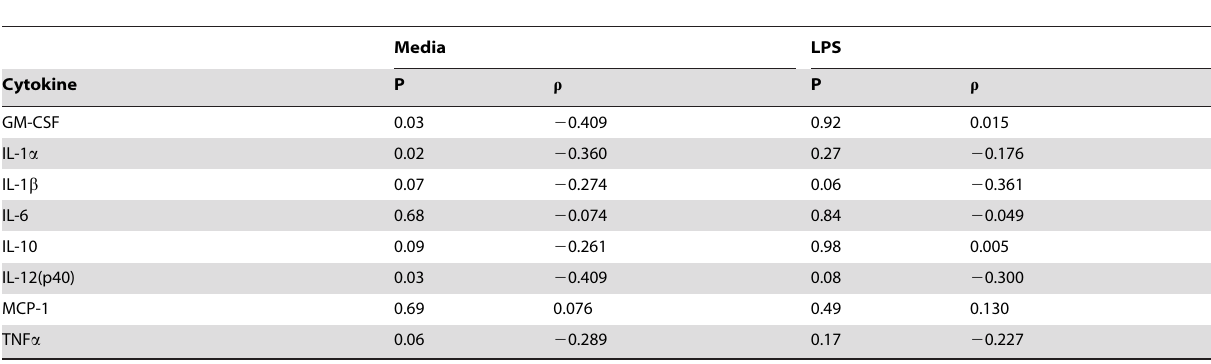
Table 1. CGG Repeat length vs. Cytokine production from human monocytes.